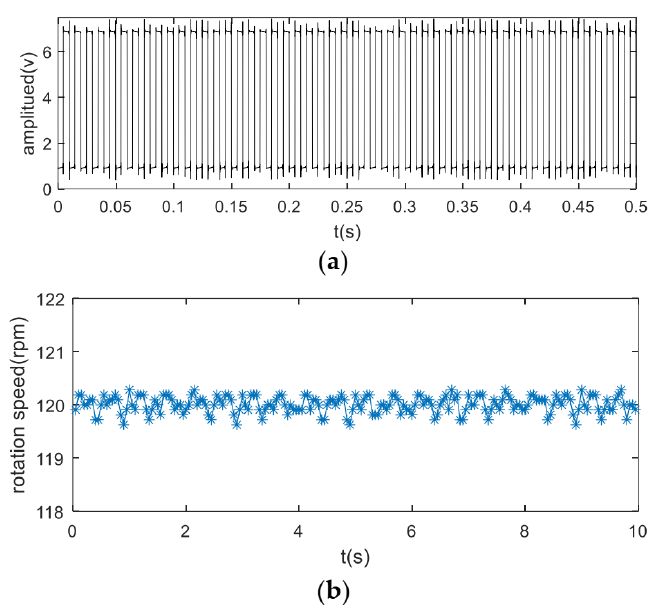
Figure 8. Waveform plots: ( a ) encoder pulse train ( b ) shaft speed plot.